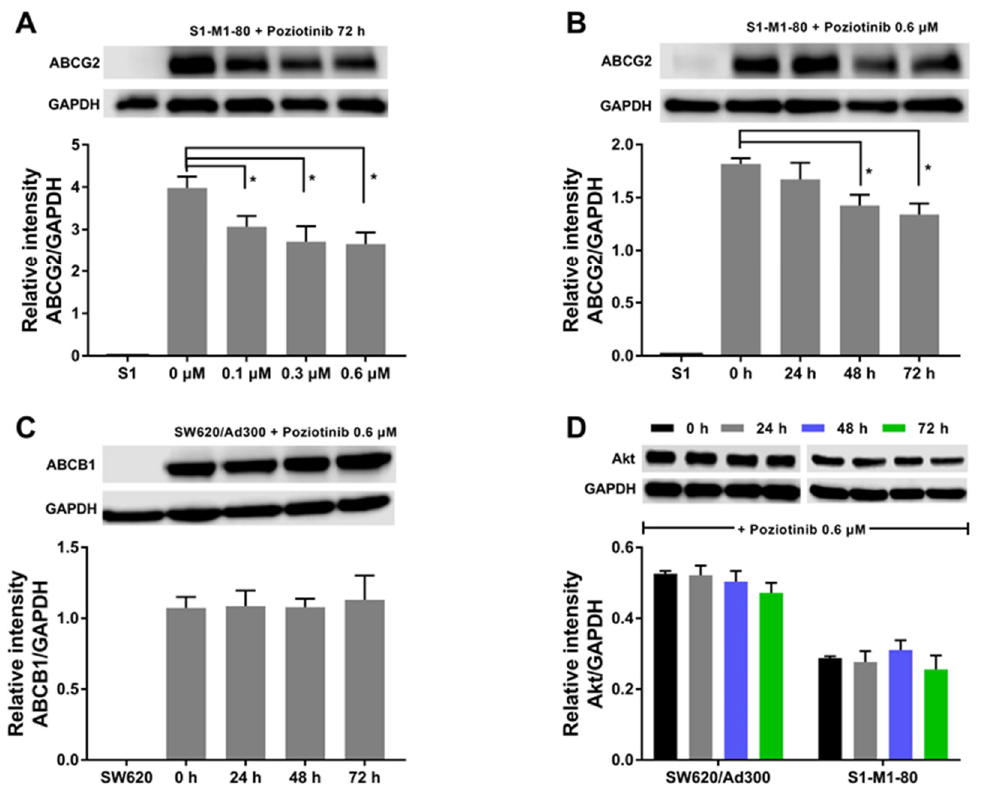
Figure 2. The e ff ect of poziotinib on the expression level of the ABCB1 and ABCG2 transporter protein. ( A ) The e ff ect of poziotinib on the expression level of ABCG2 in S1 and S1-M1-80 cells after 72 h of incubation ( B ) The e ff ect of 0.1, 0.3 and 0.6 µ M of poziotinib on the expression level of the ABCG2 protein in S1 and S1-M1-80 colon cancer cells after 72 h of incubation. ( C ) The e ff ect of poziotinib on the expression level of ABCB1 transporter protein in SW620 and SW620 / Ad300 colon cancer cells after 72 h of incubation. ( D ) The e ff ect of poziotinib on the expression level of Akt in SW620 / Ad300 and S1-M1-80 colon cancer cells after 72 h of incubation. Data are expressed as mean ± SD derived from three independent experiments. * p < 0.05 versus the control group. The uncropped western blots figures are shown in Figure S1.